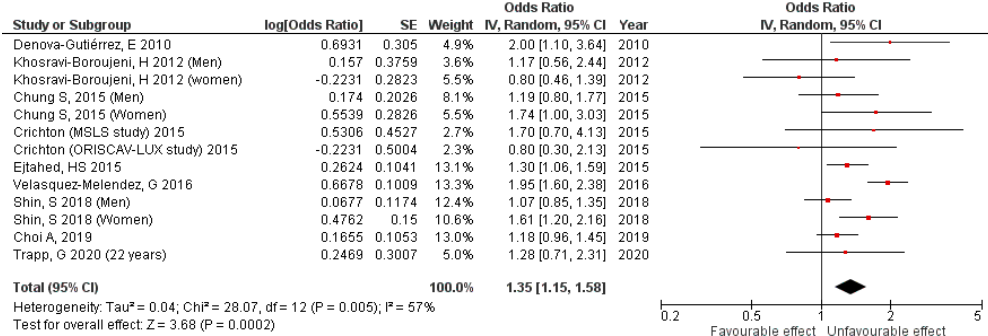
Figure 2. Cross-sectional studies forest plot.